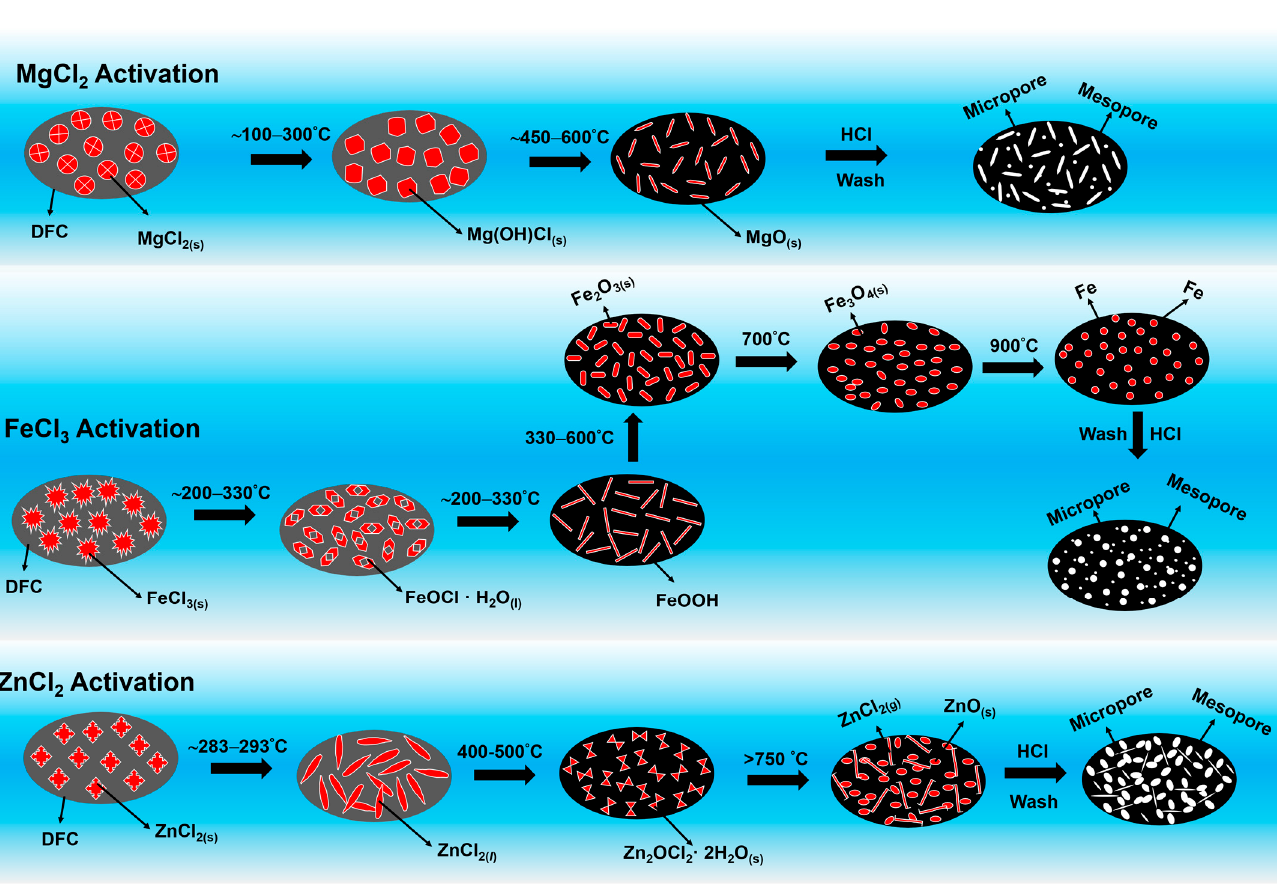
Scheme 1. Schematic illustration for the chemical activation